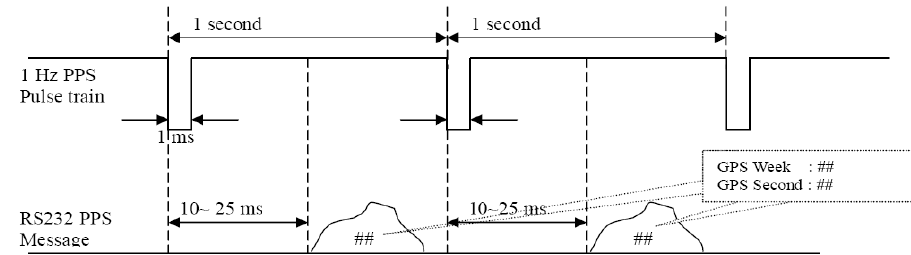
Figure 5. PPS signal and message diagram (Adapted from [21]).